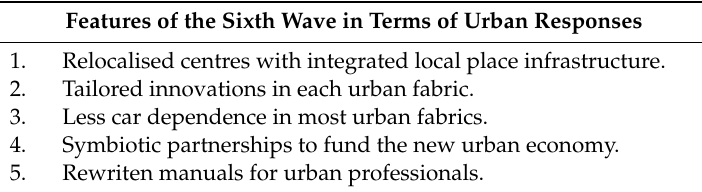
Table 2. Features of the sixth wave in terms of urban